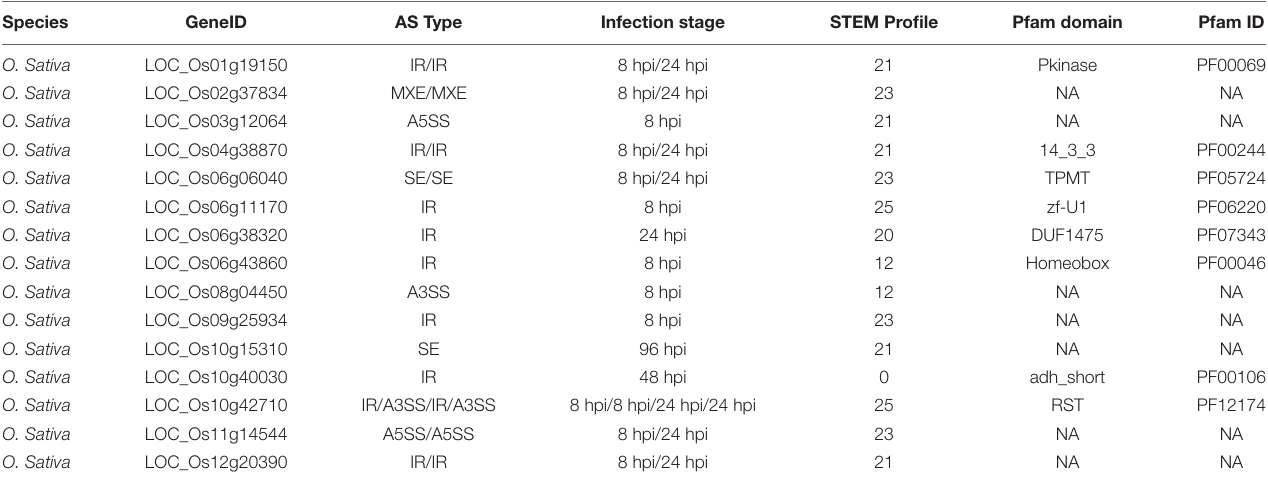
TABLE 4 | Annotation of 15 O. sativa CDEGs with 24 AS